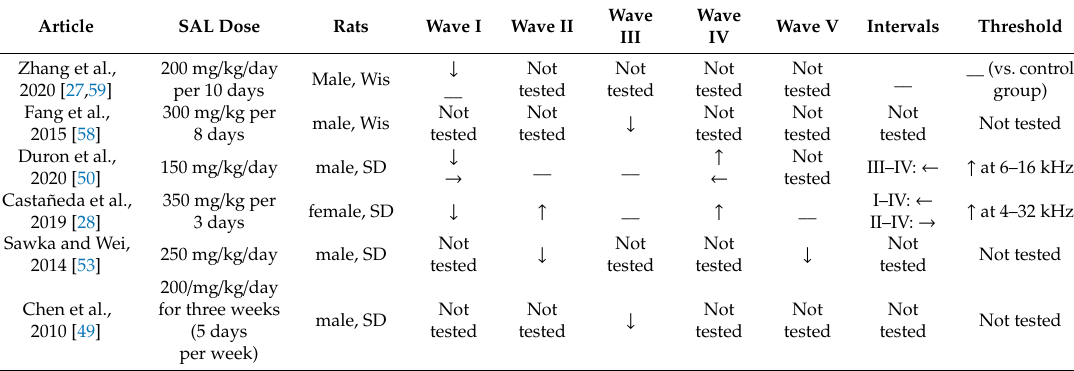
Table 4. Salicylate-induced changes in ABR amplitude and